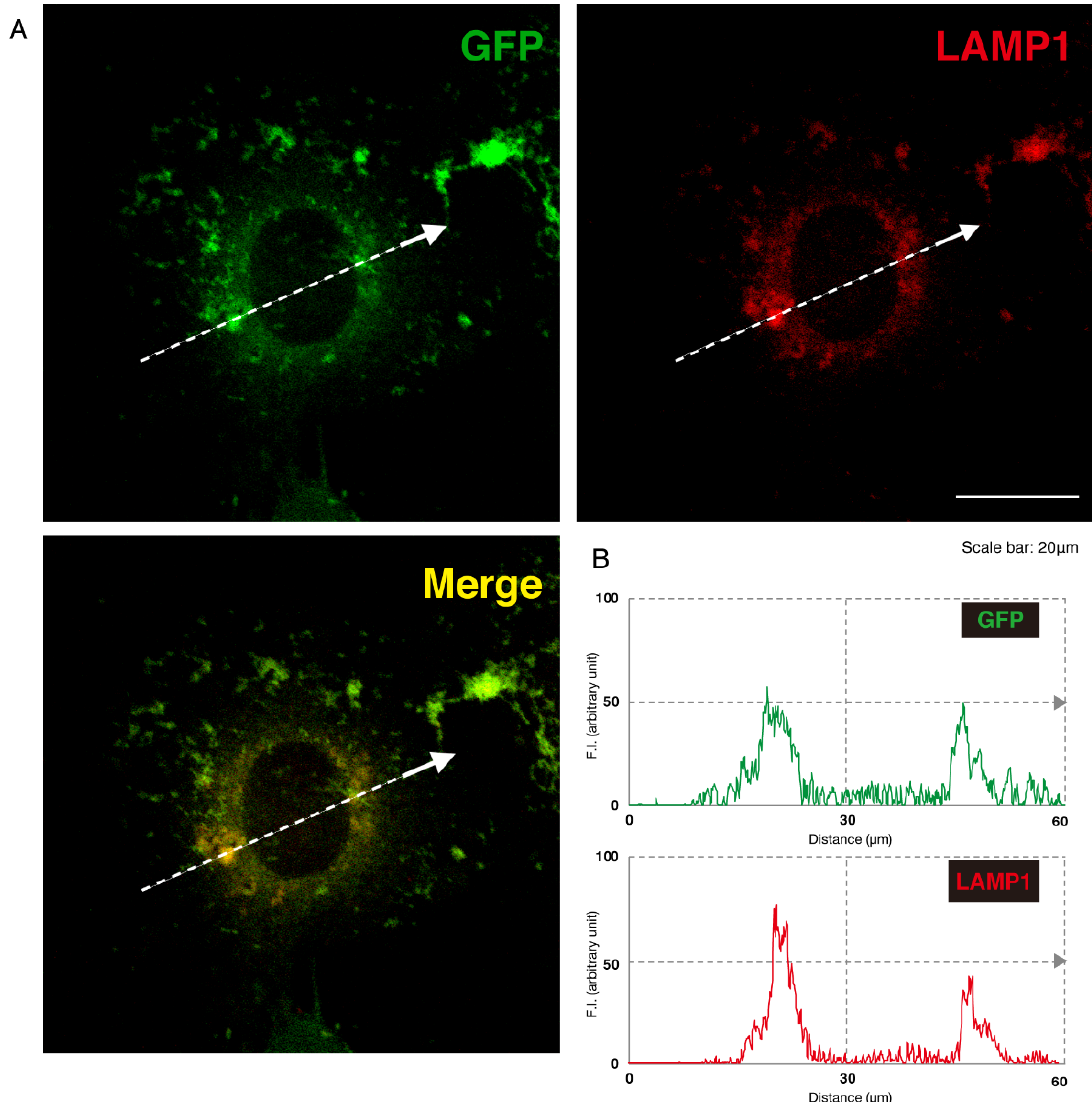
Figure 6. The 292CA mutant proteins are colocalized with the lysosome marker. ( A ) N1E-115 cells were transfected with the plasmid encoding the 292CA mutant construct of GFP-tagged AIMP1 (green). Transfected cells were stained with an antibody against the lysosome marker LAMP1 (red). A merged image with a dotted arrow is also shown in the bottom panel. The scale bar indicates 20 μ m. ( B ) Fluorescence intensities (F.I., arbitrary unit) of green and red colors are shown along dotted arrows in A.